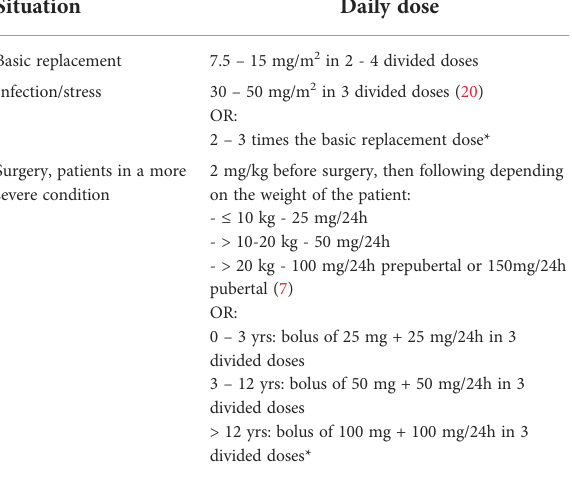
TABLE 4 Proposed replacement doses of hydrocortisone in children in central adrenal insuf fi ciency, depending on the stressful situation, with the authors ’ modi fi cation (7,